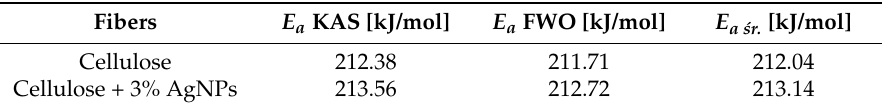
Table 3. Activation energy values.